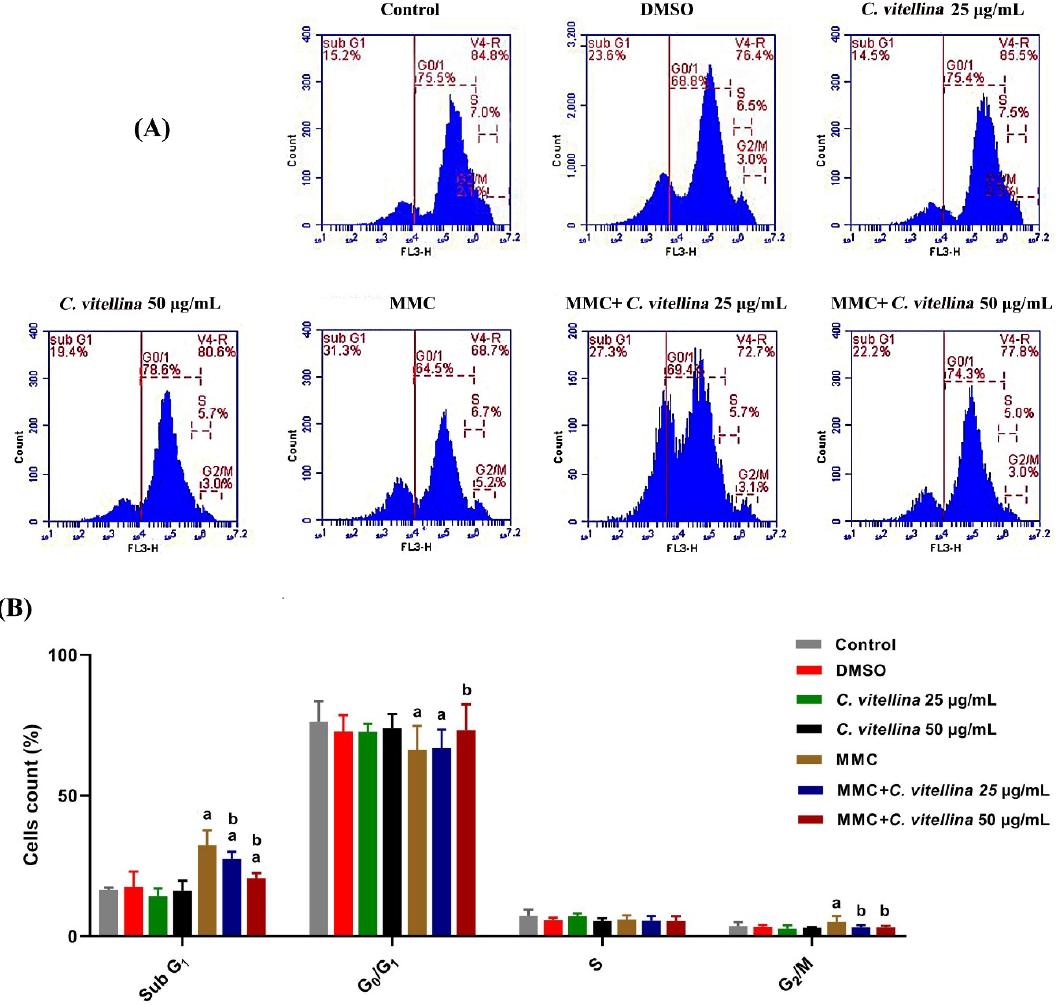
Figure 4. Representative graphs showing the ameliorative effect of C. vitellina extract on HPBL cell cycle distribution against MMC-induced alterations, 24 h, using PI staining ( A ). The percentages of cells’ distribution among cell cycle phases are illustrated in the histograms ( B ). The statistical differences ( p ≤ 0.05), compared to untreated control cells (a) and to MMC-treated groups (b). Data were represented as (Mean ± SD) of three different experiments (n = 3). MMC: Mitomycin C (0.5 µg/mL).